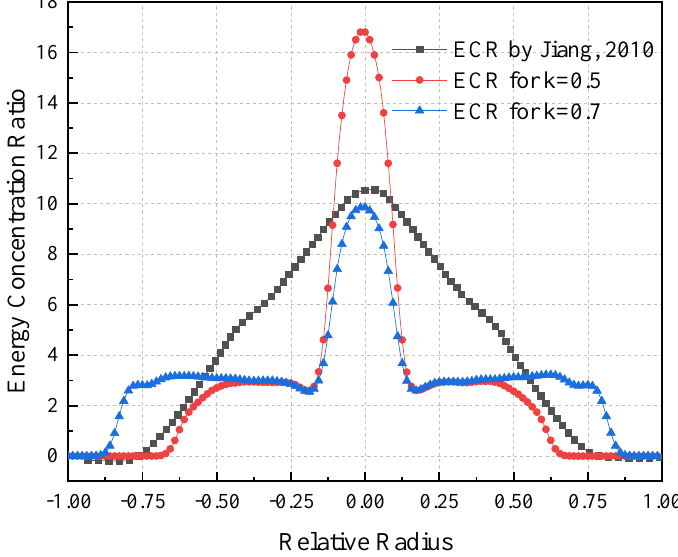
Figure 15. Comparison of ECR distribution in TFSC and Ref [23].